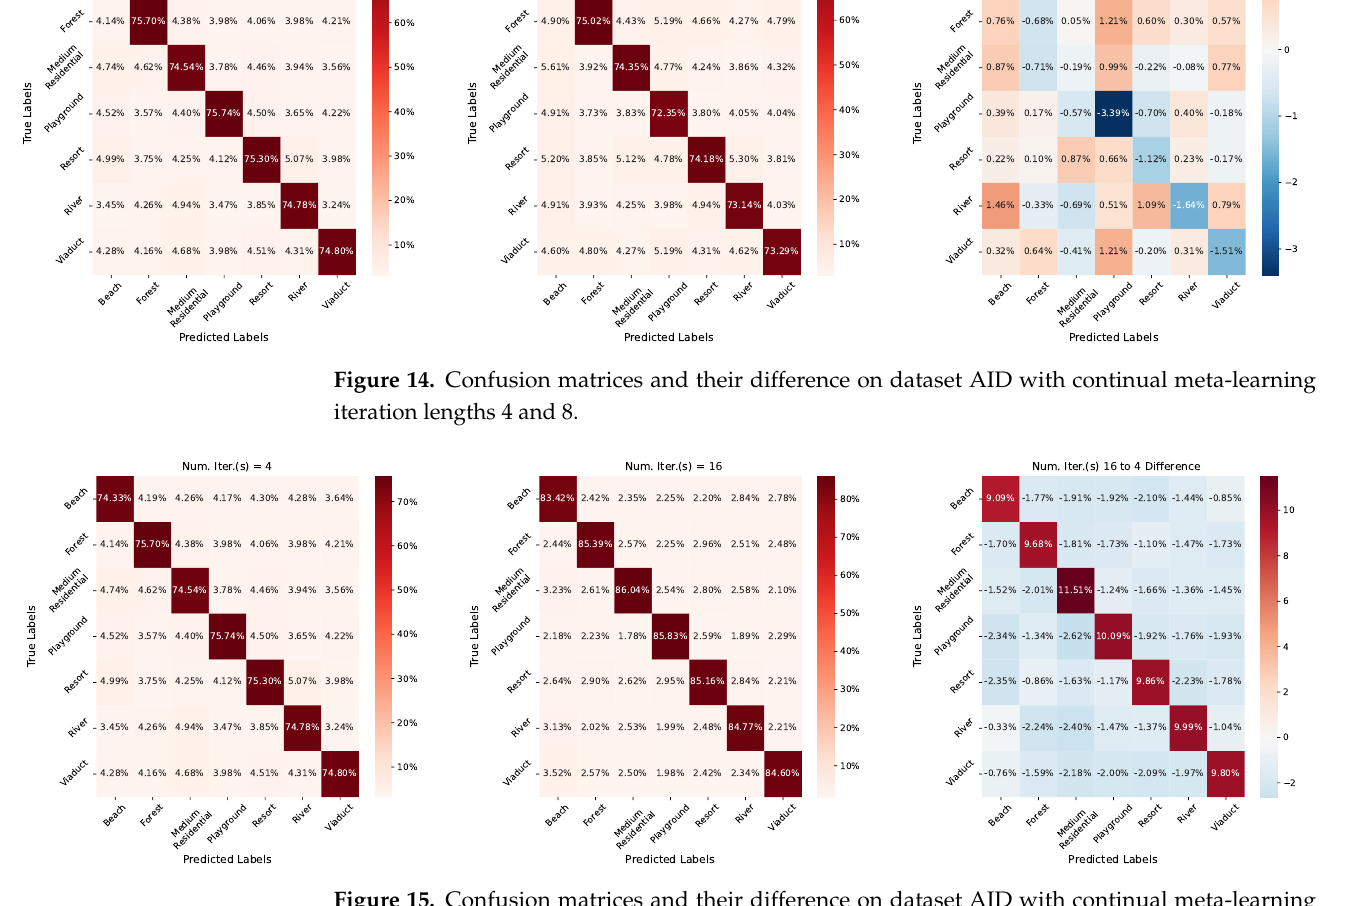
Figure 15. Confusion matrices and their difference on dataset AID with continual meta-learning iteration lengths 4 and